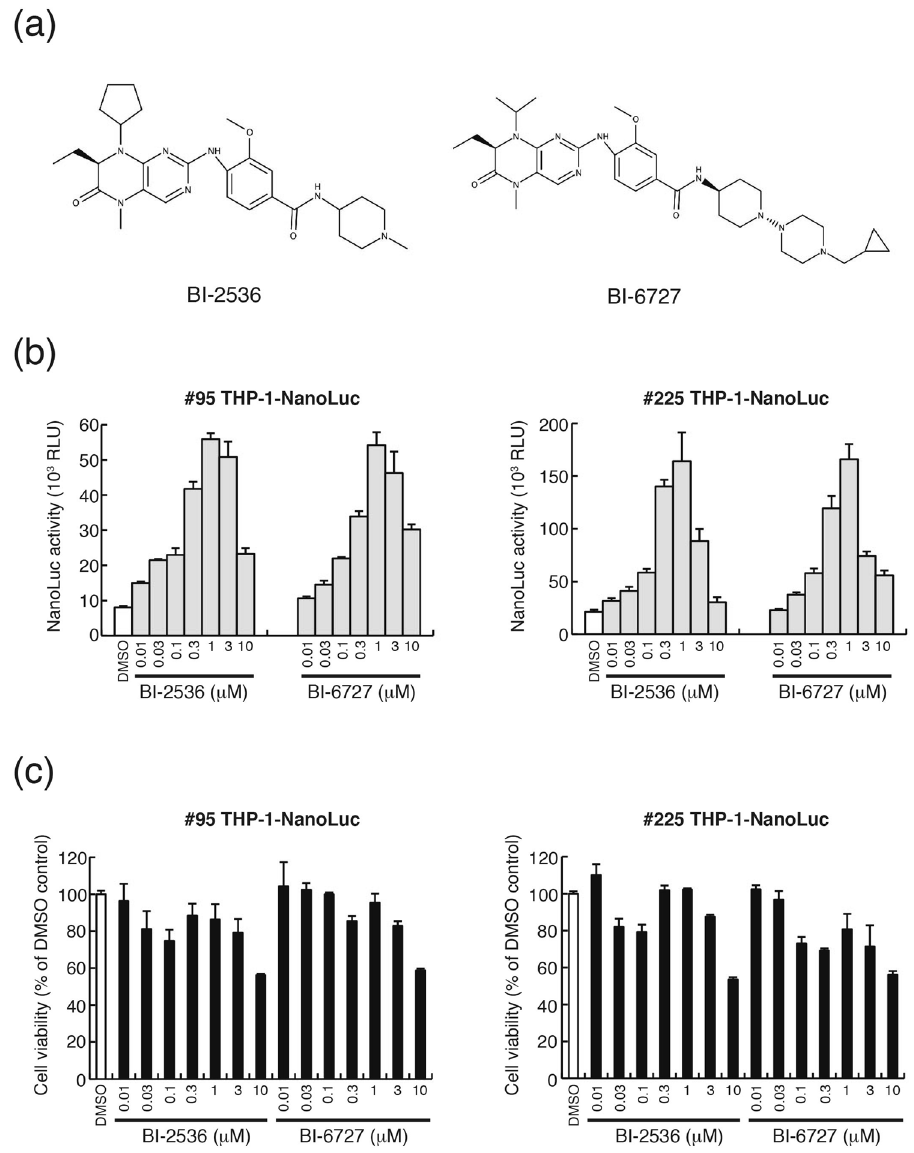
Figure 2. BI-2536 and BI-6727 induce NanoLuc activity in THP-1-NanoLuc clones. ( a ) The structures of BI-2536 and BI-6727. ( b ) #95 THP-1-NanoLuc clone and #225 clone cells were cultured in the absence (0.1% dimethyl sulfoxide [DMSO]) or presence of BI-2536 or BI-6727 at the indicated concentrations for 24 hours. The cells were then harvested and lysed. NanoLuc activity of the cell lysates was determined. Each value is shown as a mean ± standard deviation (SD) of triplicate samples. ( c ) #95 and #225 THP-1-NanoLuc clone cells were cultured in 0.1% DMSO or in the presence of BI-2536 or BI-6727 at the indicated concentrations for 24 hours. Cell viability was measured by a WST-8 assay and shown as a percentage of that of DMSO control cells. Each value is shown as a mean ± standard deviation (SD) for triplicate